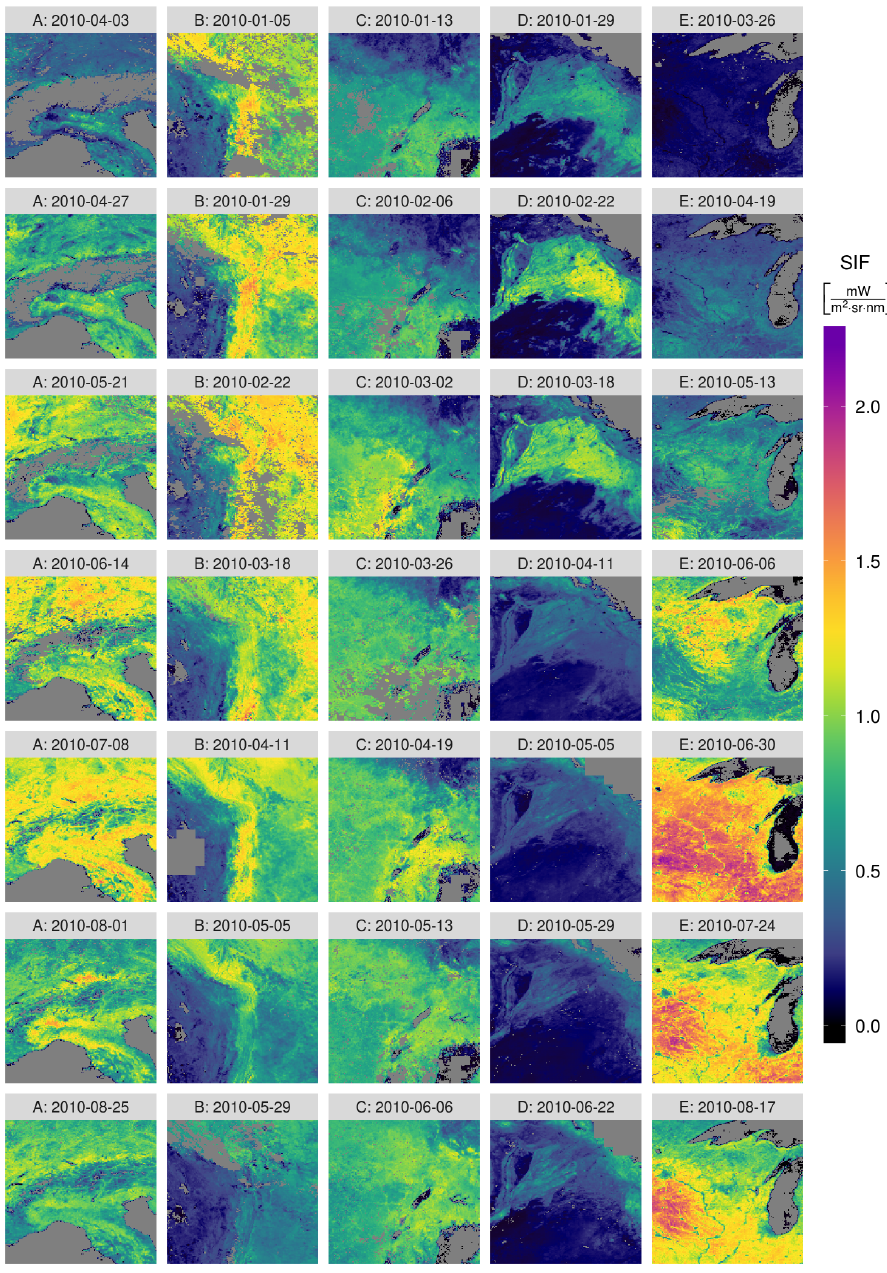
Figure 4. Selection of spatio-temporal subsets of the newly downscaled PK SIF product. Each box covers a region of 8 ◦ × 8 ◦ , covering parts of (A) the European Alps and their surroundings, (B) Bolivia, (C) the African Great Lakes, (D) the Indus Valley and the Indo-Gangetic Plain, and (E) the US Corn Belt (the locations of these areas are shown in Fig. 5). The corresponding time is mentioned above each image. Although the temporal frequency of the dataset is 8d, only an image every 24d is presented here to accentuate the seasonal dynamics. Notice also that the five time series are not synchronised. Grey areas indicate lack of